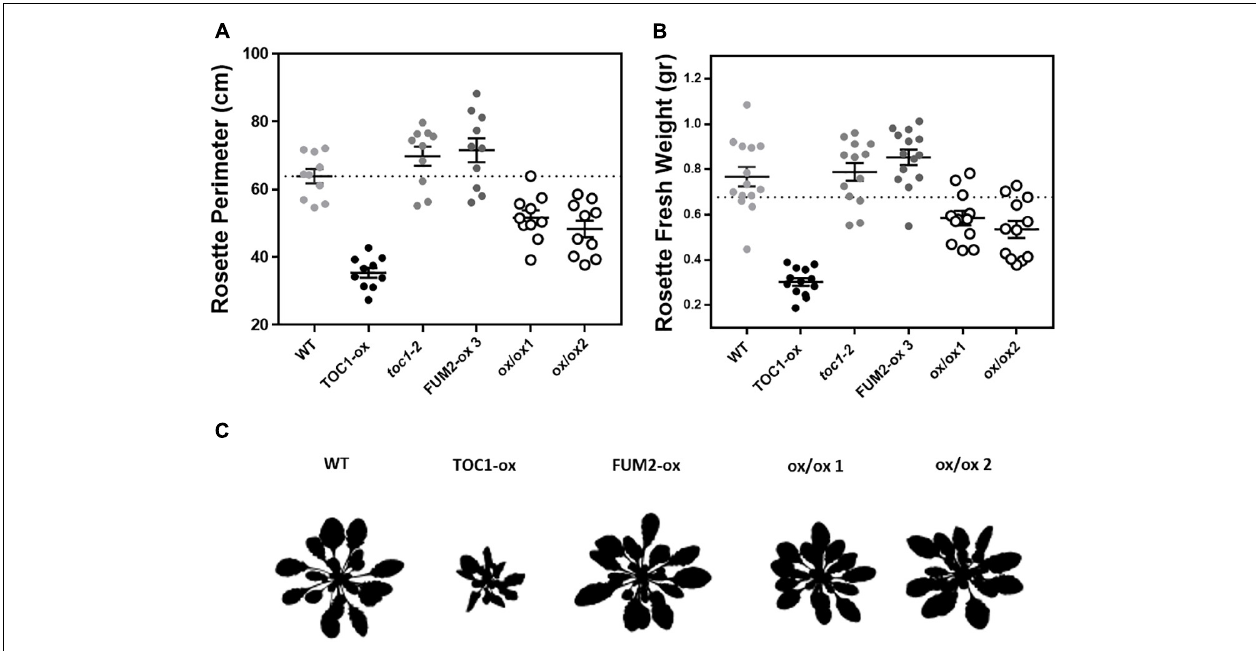
FIGURE 6 | Over-expression of FUM2 partially restores the molecular and physiological phenotypes of TOC1-ox. Rosette (A) perimeter and (B) fresh weight of the indicated genotypes grown under long day (LgD) conditions. Every dot represents a single rosette. Dotted lines show the mean of WT. (C) Rosette 8 bits images. Data are represented as the mean + SEM. Three biological replicates were performed for all experiments, with plants grown independently, with samples collected, processed and analyzed at different